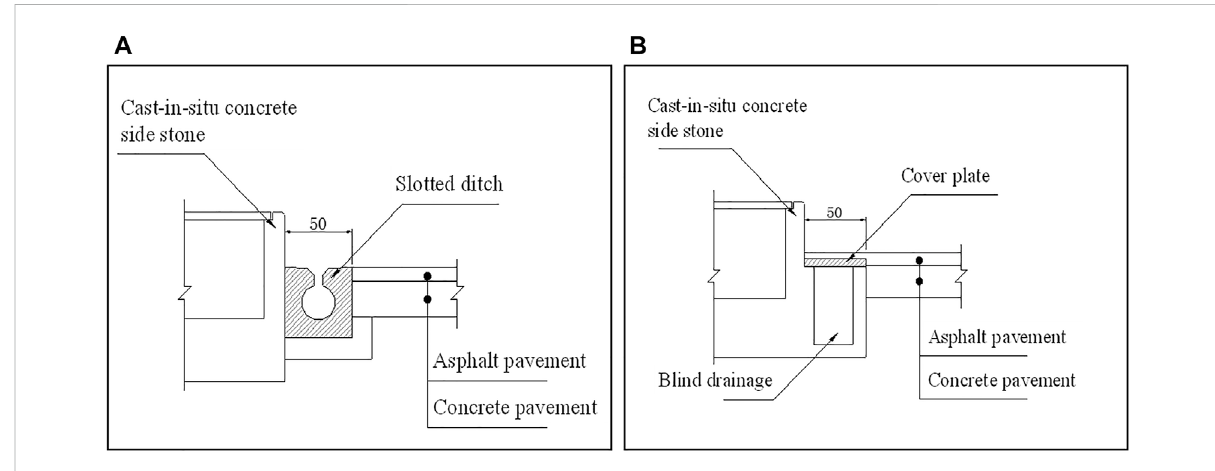
FIGURE 2 The tunnel curb components: (A) slotted ditch, (B) blind drainage.